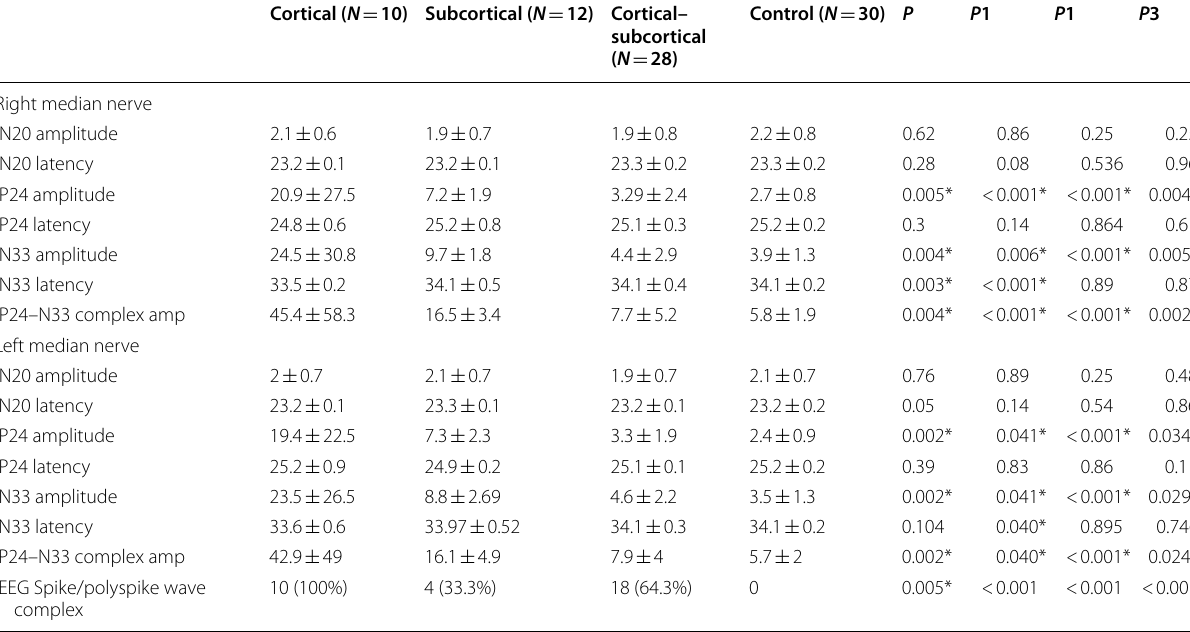
Table 5 SSEPs findings in different myoclonus subtypes according to anatomical